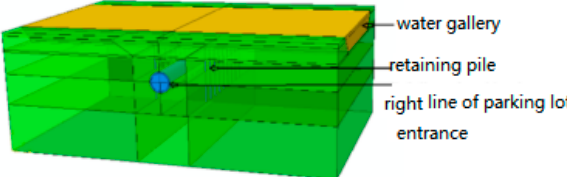
Figure 7. Overall map of the right line of the tunnel and the water gallery model.